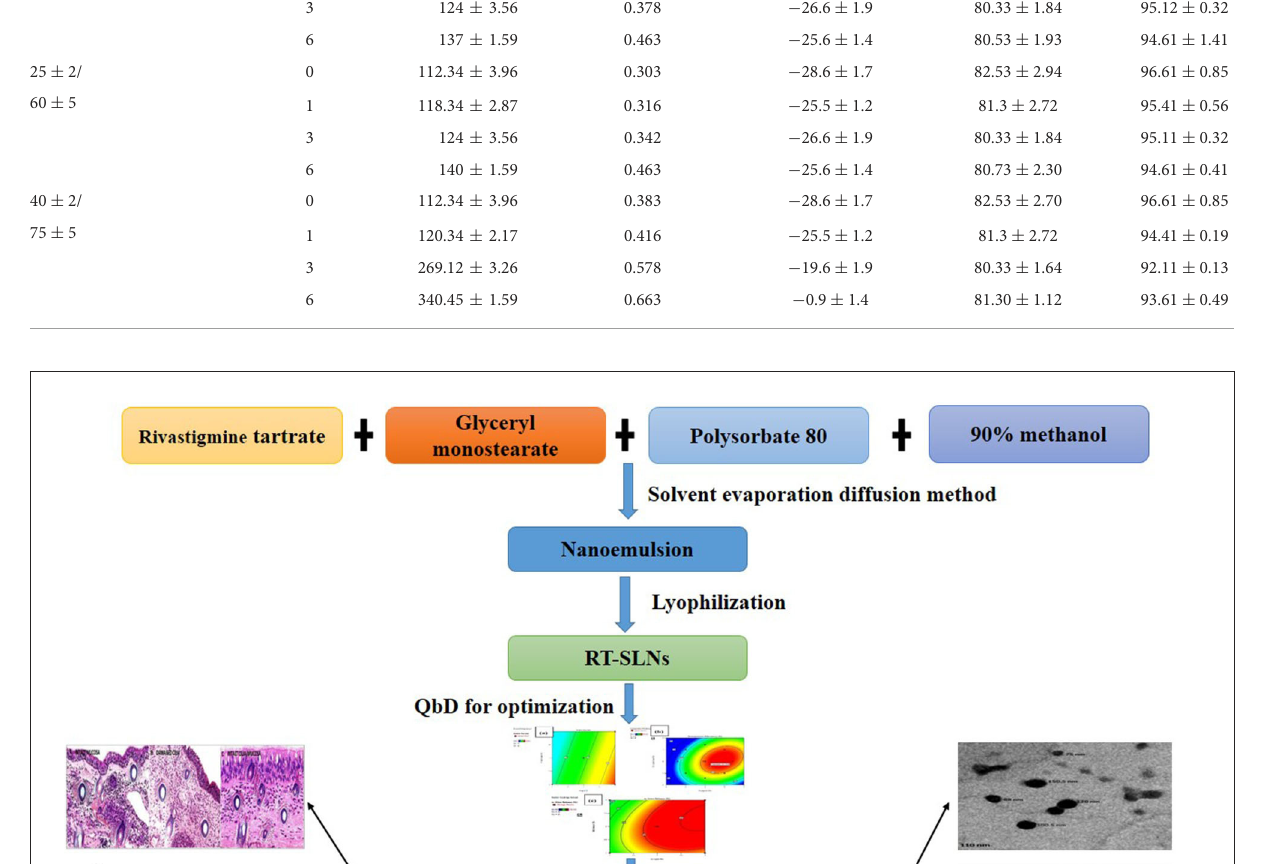
TABLE 5 Results of stability studies of optimized RT-SLN formulations ( n = 3). Temp ◦ ( C)/RH (%)